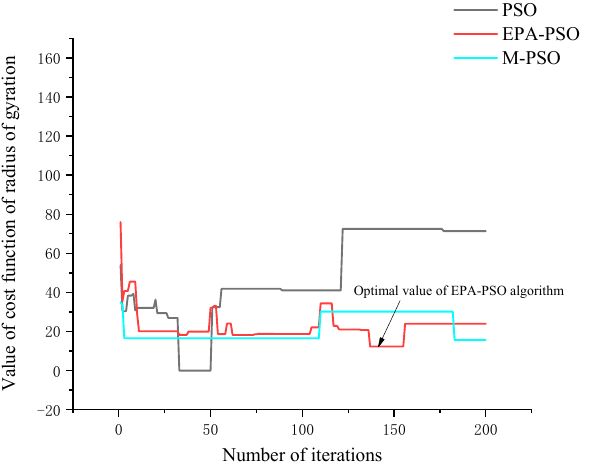
Figure 16. Numerical comparison of cost functions of radius of gyration after 100 iterations.